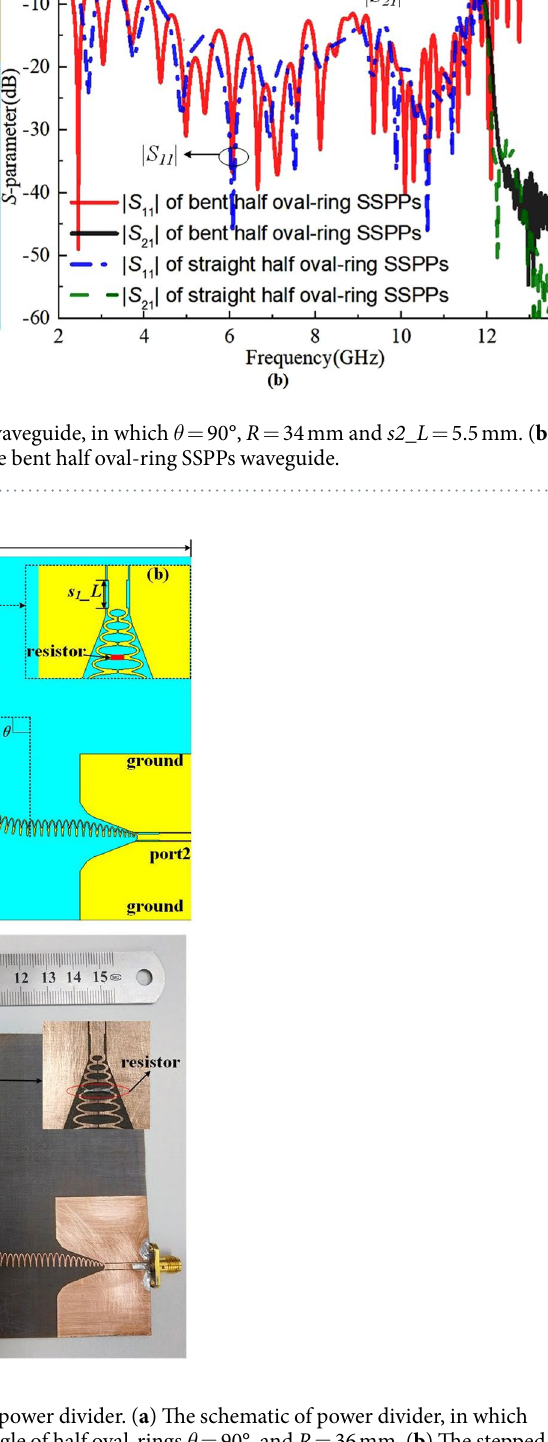
As is shown in Fig. 1(f), the magnetic field distribution of SSPPs wave is highly localized in the grooves of the SSPPs waveguide, leading to a weakened electromagnetic energy in the middle of the oval-ring structures. Thus, a narrow gap in the middle of the oval-ring SSPPs waveguide is adopted to add the isolated resistance. Figure 5(d)